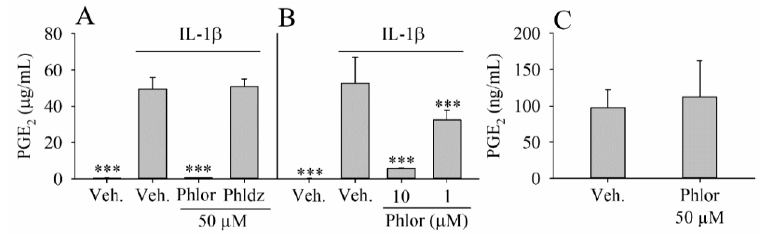
Figure 2. PGE 2 level in culture medium of myofibroblast of colon CCD-18Co treated with ( A ) IL-1 β (1 ng / mL) alone or in combination of Phlor or Phldz (50 µ M); ( B ) IL-1 β (1 ng / mL) alone or in combination of Phlor (10 and 1 µ M); ( C ) Phlor (50 µ M). The results are expressed as mean ± standard deviation